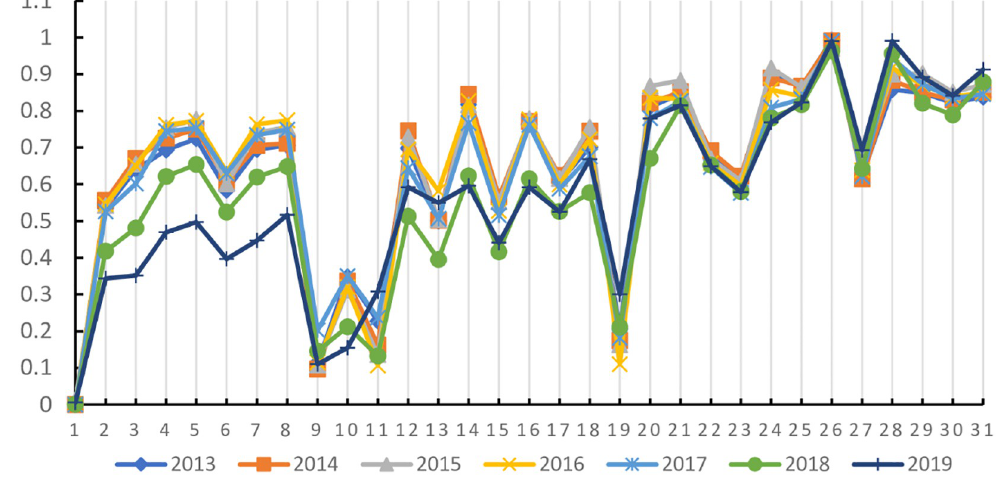
Fig 4. Chart of the changing trend of digital economy development level in China’s provinces from 2013 to 2019.